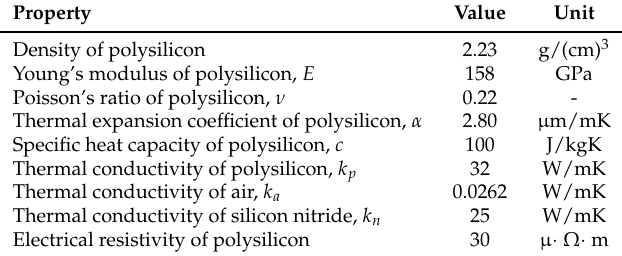
Table 2. Material properties utilised in this work as obtained from the Coventorware (cid:114) Materials Library for the PolyMUMPs TM fabrication process. All properties in this table are given at room temperature (300 K) and all references to polysilicon refer to the Poly2 layer.